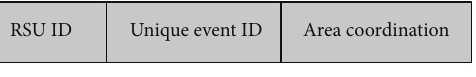
Figure 11: Beacon message structure.